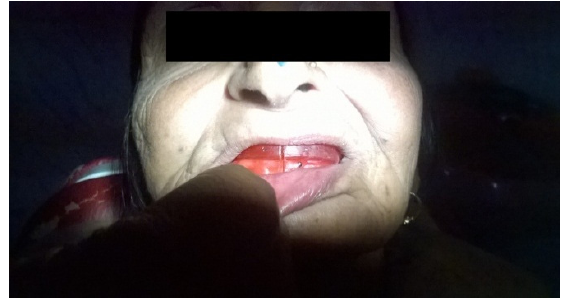
Figure 6. Maxillo-mandibular